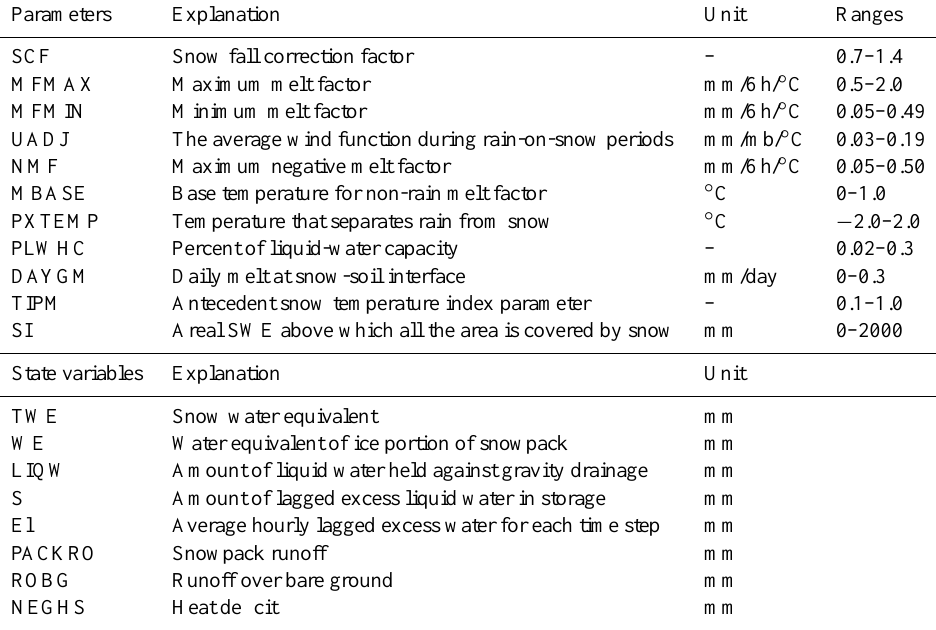
Table 1. SNOW17 model parameters and state variables that are updated in the data assimilation applications. Parameter ranges are estimated from Anderson (1973) and He et al.